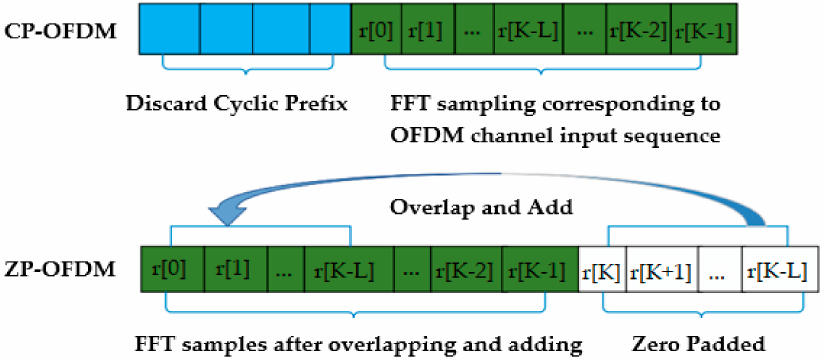
Figure 7. The receiving process of CP-OFDM and ZP-OFDM